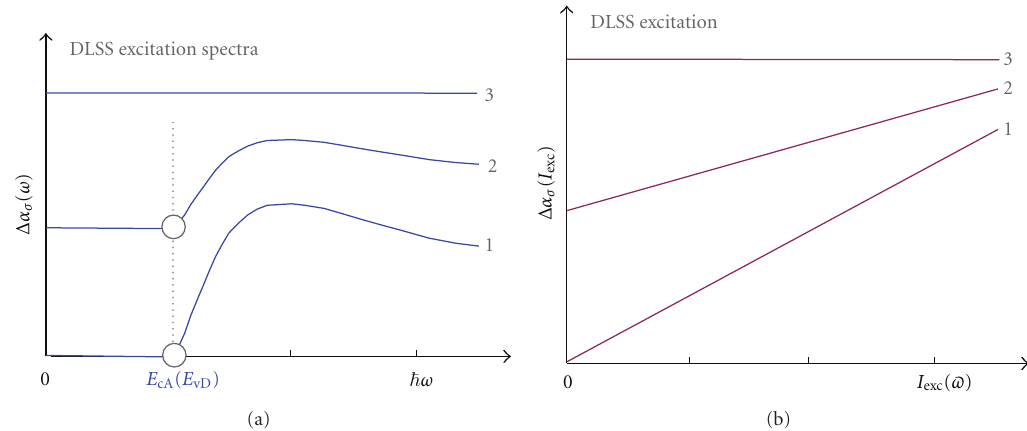
Figure 8: Excitation spectra of DLSS (a) and intensity dependences on I ( ω ) of the photoneutralizing part of illumination with (cid:2) ω > E g − E M . Ratios of the localized carrier lifetimes: 1 − τ (cid:8) τ ∗ ( σ cD (cid:8) σ vD or σ vA (cid:8) σ cA , compensated centers); 2 − τ ≈ τ ∗ ;3 − τ (cid:10) τ ∗ (uncompensated